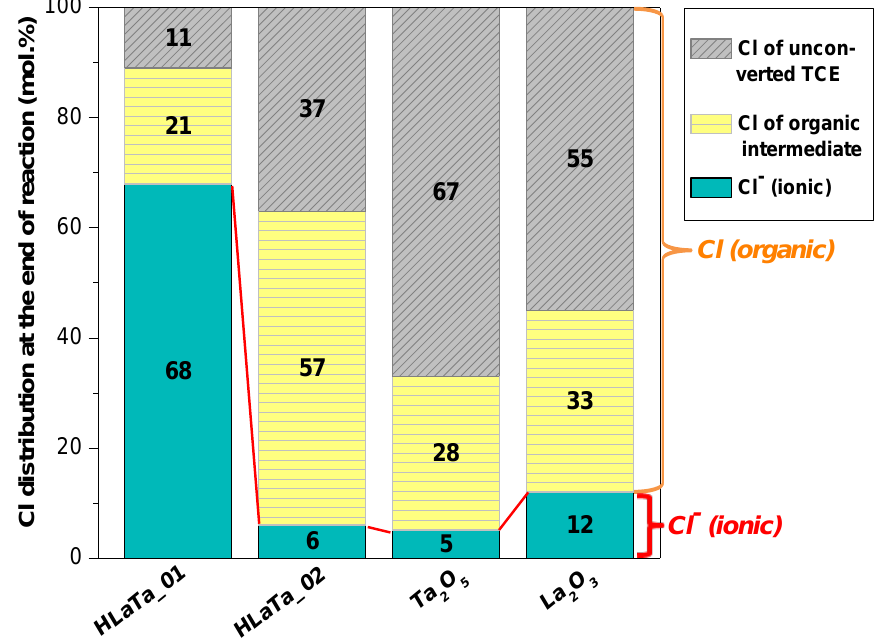
Figure 13. Chlorine distribution after 5 h of reaction time over HLaTa_01(02) protonated photocatalysts and the commercial oxides.